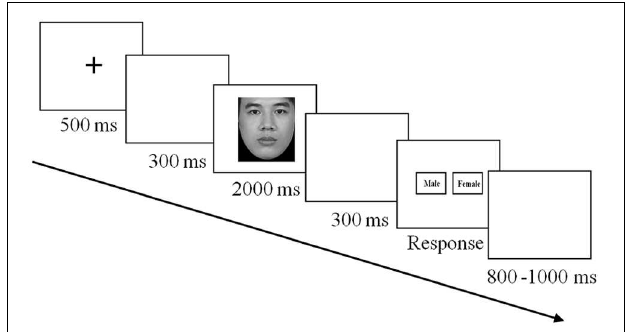
FIGURE 2 | Sequence of events in the gender judgment